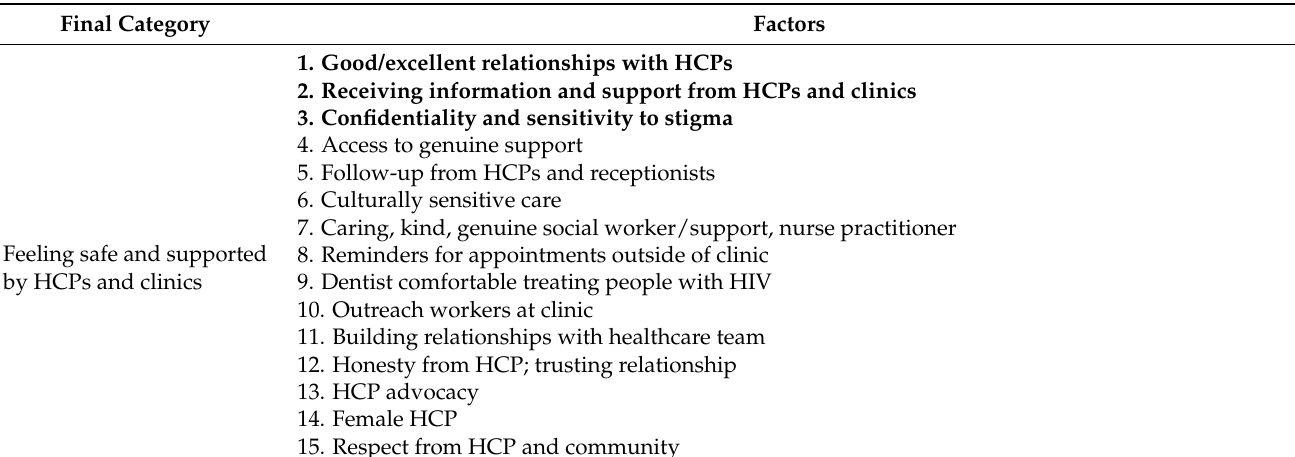
Figure 2. Literature-based map synthesizing findings from Cooper et al. on the factors that influence satisfaction with HIV care among people living with HIV. Table 2. Categorization of factors influencing satisfaction with HIV care among women living with HIV. Factors retained from the literature-based map in grey.